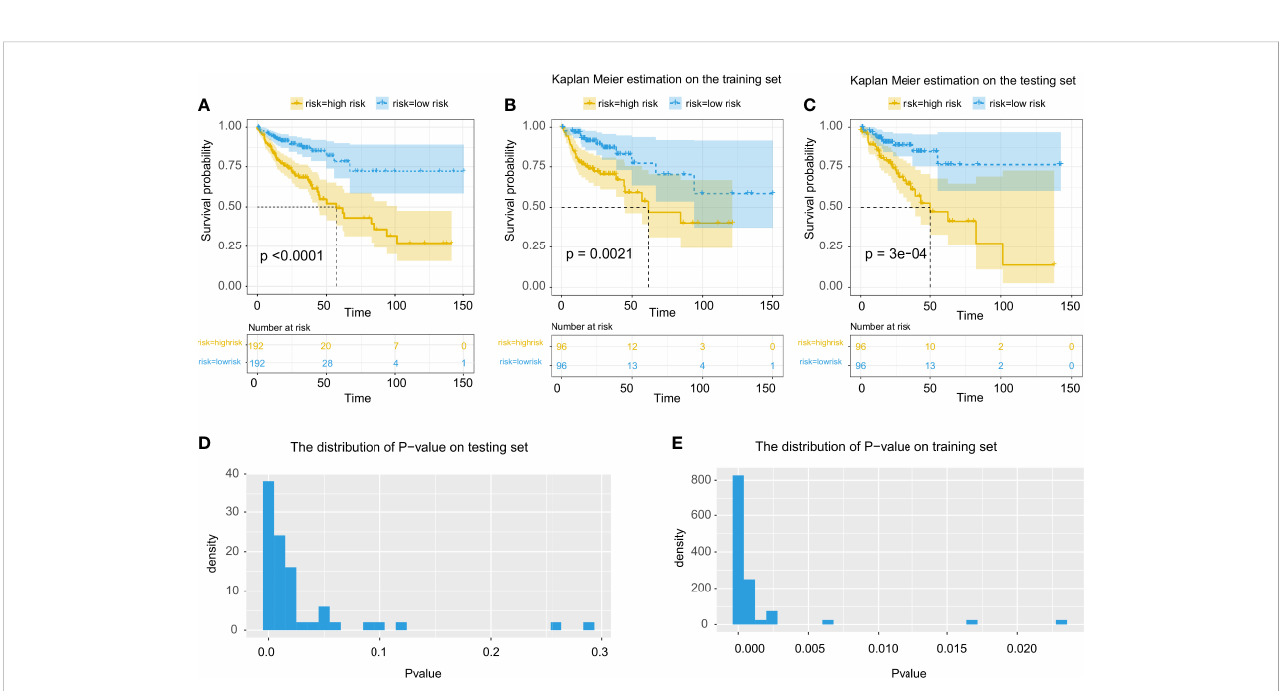
FIGURE 4 Evaluation of the prognostic prediction model using features extracted from cells in tumor region. (A) Multivariate cox regression for all patients using all prognosis-related morphological features. (B, C) Kaplan Meier estimate using multivariate cox regression on training and testing data. (D, E) Statistical evaluation and demonstration of the prognostic prediction model using selected prognosis-related morphological features on the testing set and the training